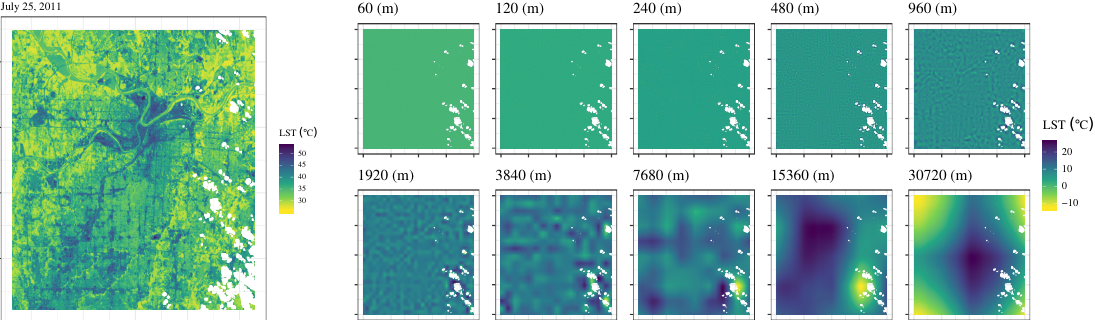
Figure 2. Ten-level wavelet decomposition ( right ) of the land surface temperature (LST) image from 25 July 2011 ( left ). The levels of decomposition show the contribution of each pixel to LST variability at each scale. The level one 60 m decomposition was discarded from the subsequent